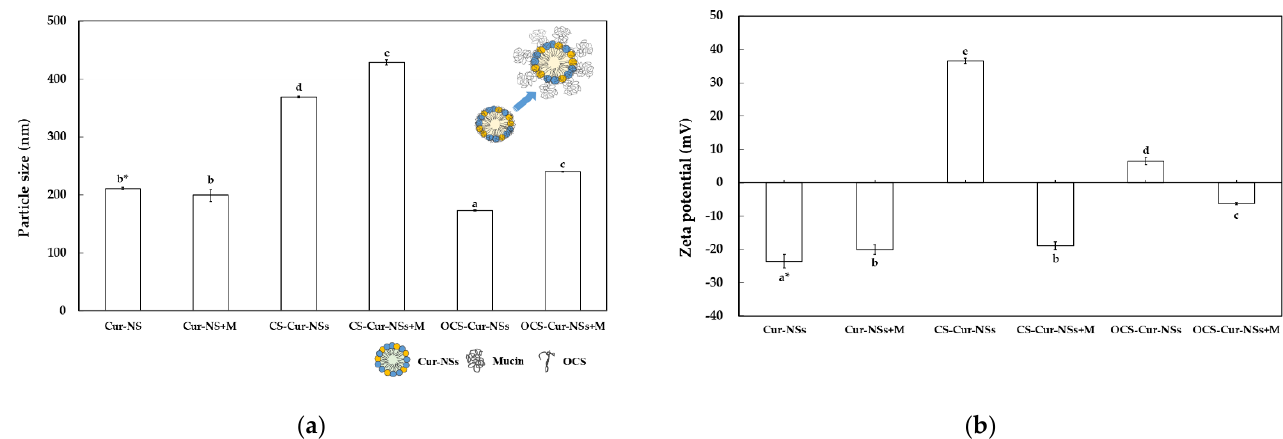
Figure 4. Particle size ( a ) and zeta potential ( b ) of Cur-NSs, CS-Cur-NSs, and OCS-Cur-NSs, before and after interaction with mucin protein. * Different letters in the same variable indicate a significant difference at p < 0.05. Error bars indicate the standard deviation.